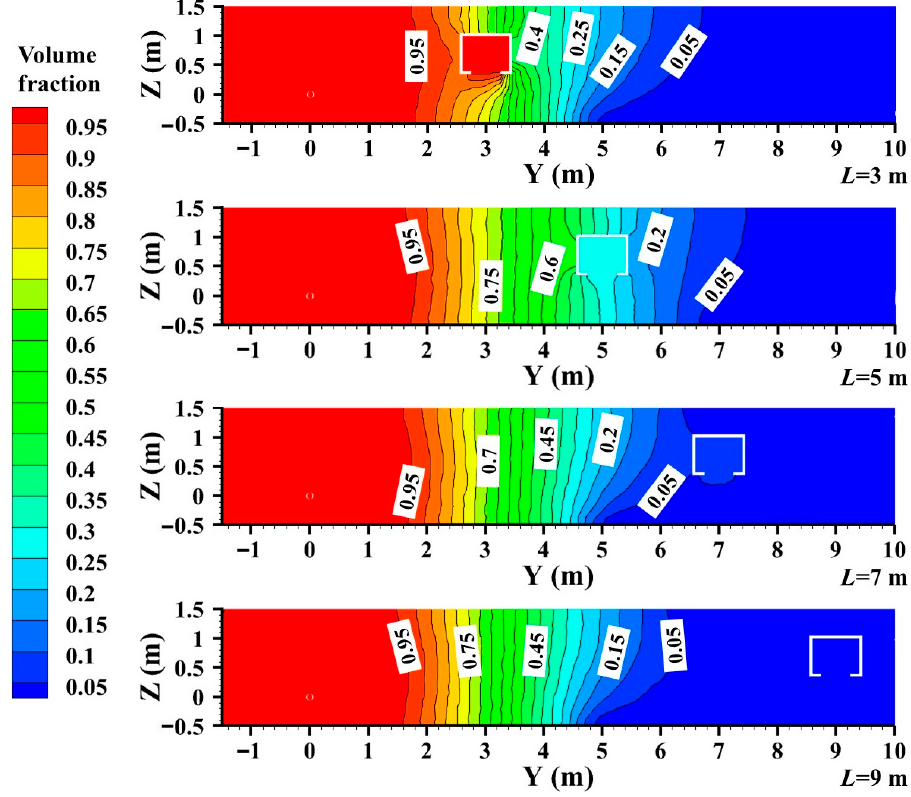
Figure 13. Influence of minimum construction distance L on gas concentration distribution in confined space.